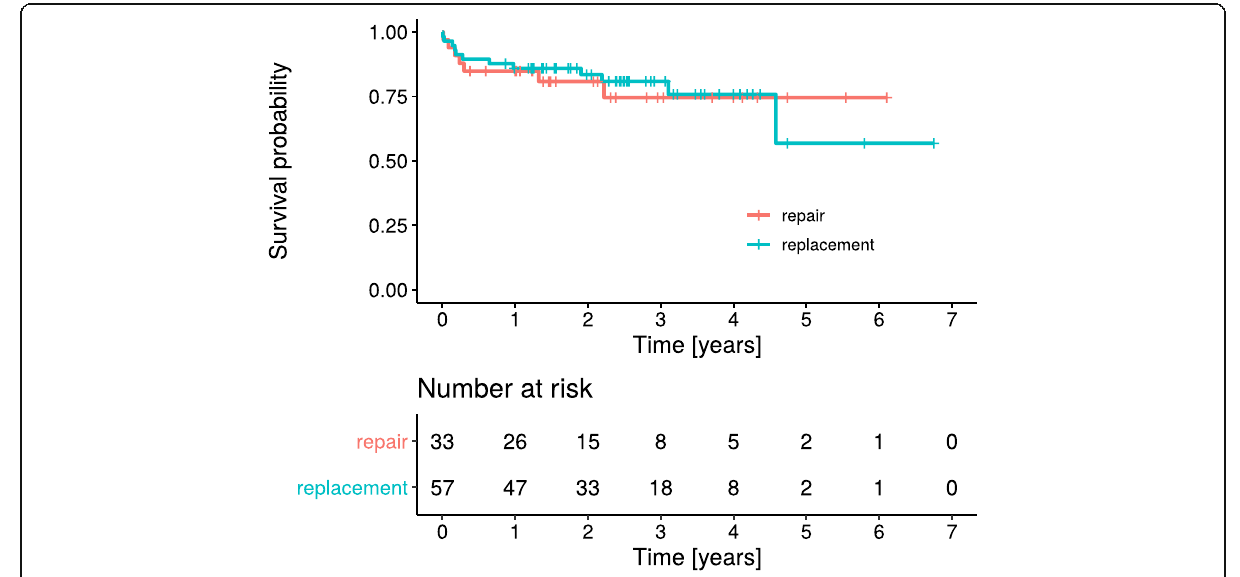
Fig. 5 Survival probability (± 95% CI) after repair and replacement procedure in